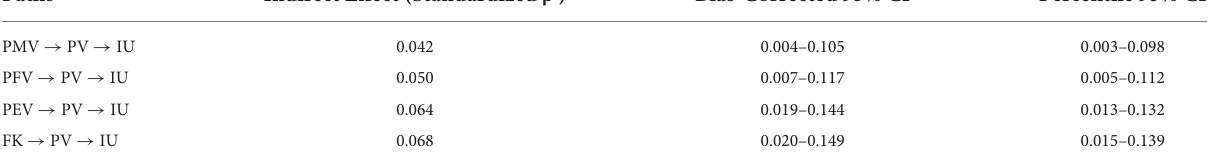
TABLE 8 Results of the mediation